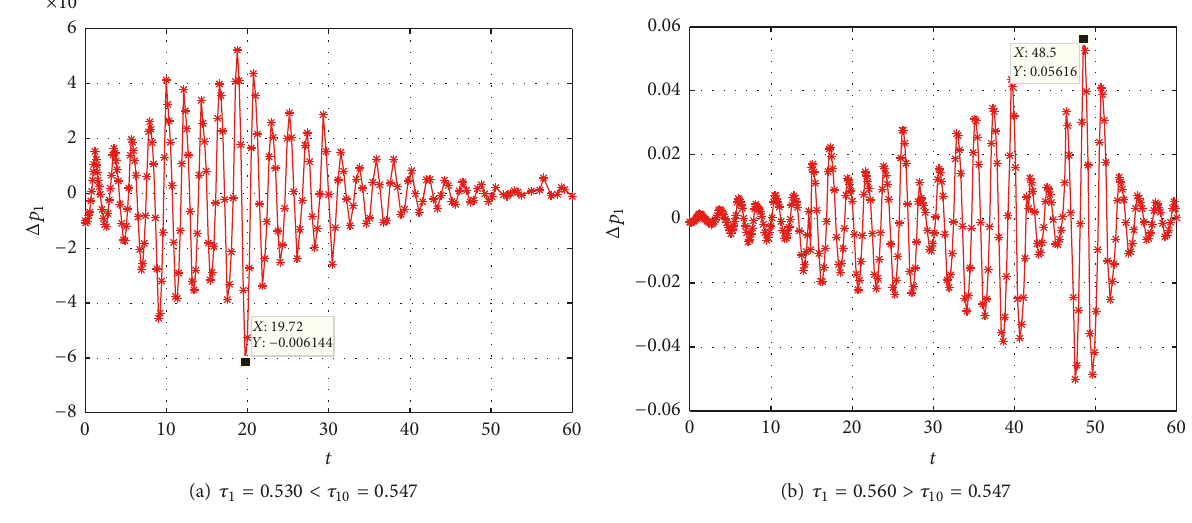
Figure 4: The sensitivity of 𝑝 1 to initial value (0.4, 0.401) when 𝜏 2 = 0.45 .